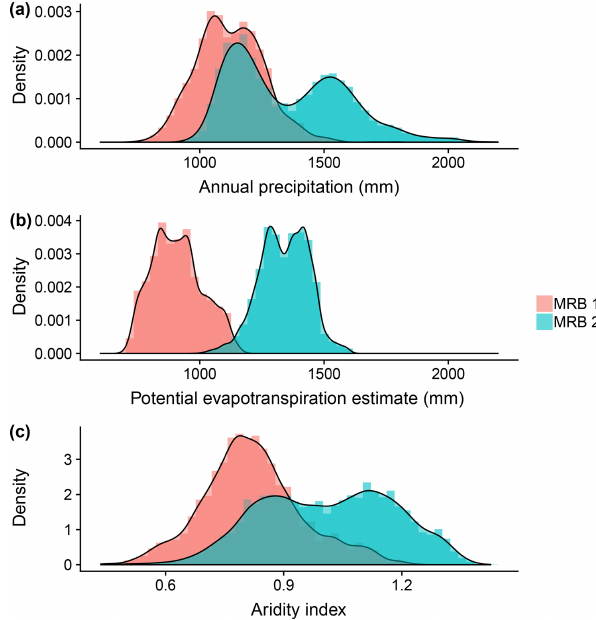
Figure 11. Distributions of (a) P , (b) E p , and (c) φ at watersheds in MRB 1 (the testing watersheds) and MRB 2 (the training water-